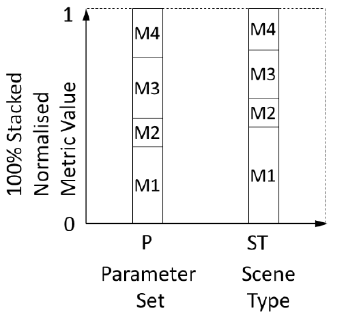
Figure 11 Performance Metric Spectrum for a particular algorithm. The metrics used to assess the algorithm are